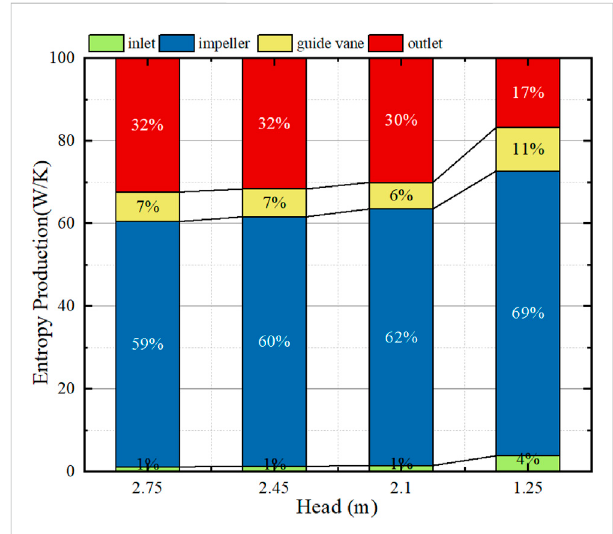
Percentage of entropy production per fl ow